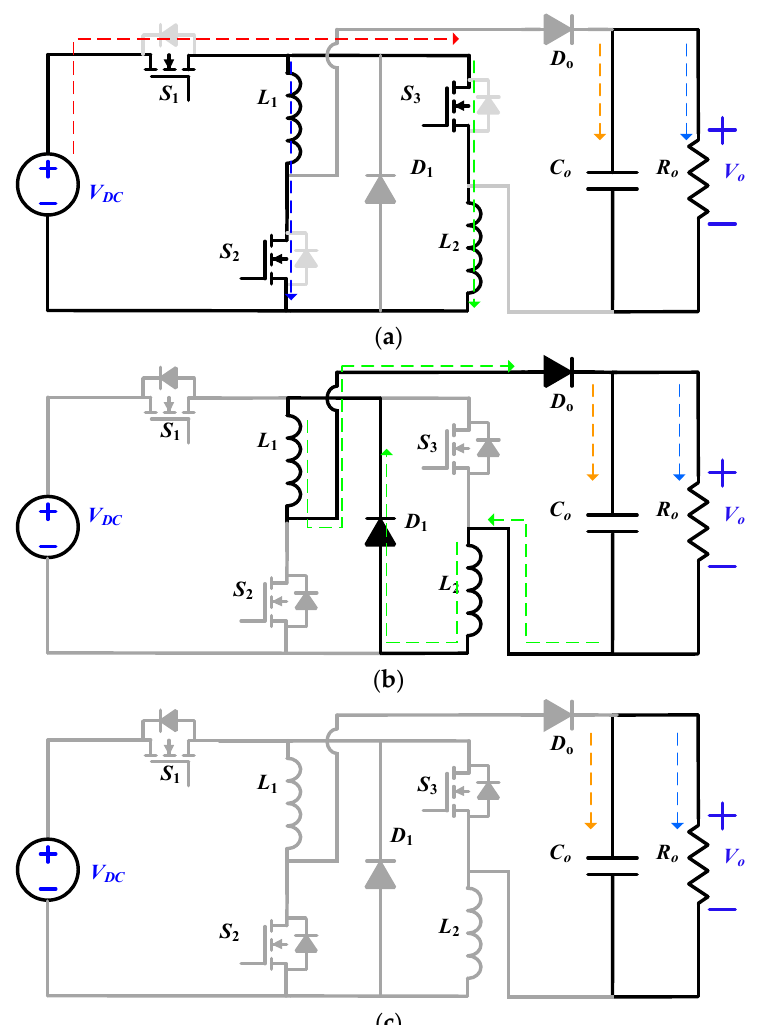
Figure 2. Operation modes of the proposed converter: ( a ) operation mode #1, ( b ) operation mode #2, and ( c ) operation mode #3.